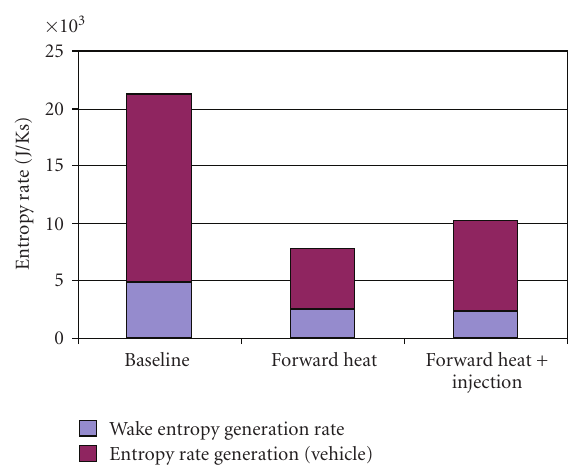
Figure 3: Entropy generation rate: blunt body at flight Mach of 10. The contribution of wake entropy production is significant. However, with strategic use of energy deposition to weaken the shock, total entropy production, and subsequent drag, is